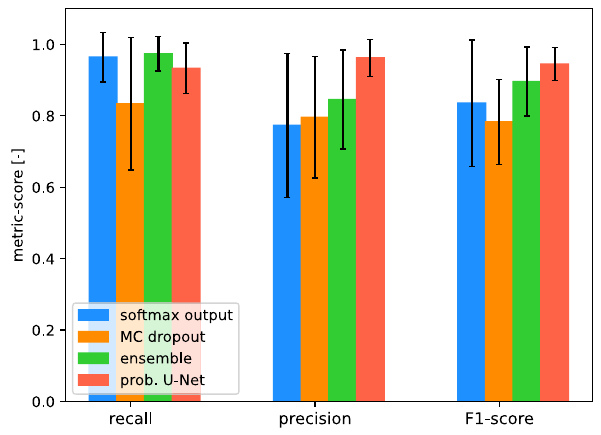
Fig. 12 Metric-scores for the dataset 3 with the round defect, and microstructure